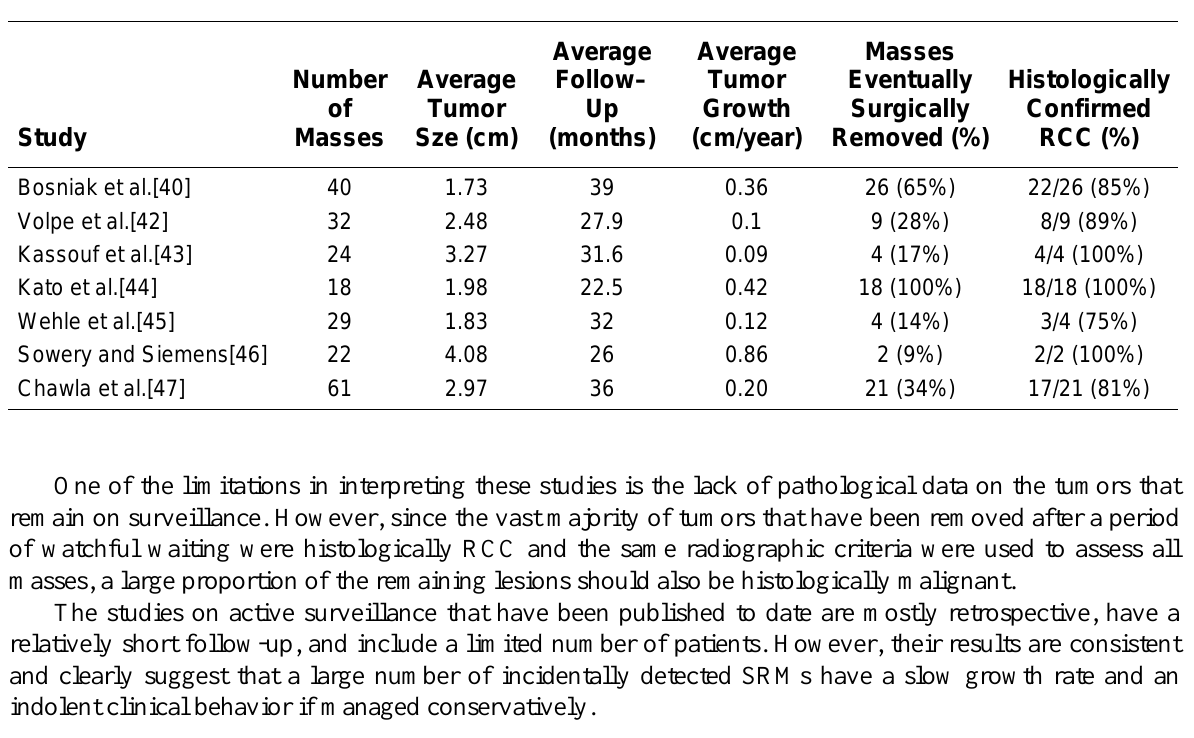
Outcomes of Studies of Active Surveillance for